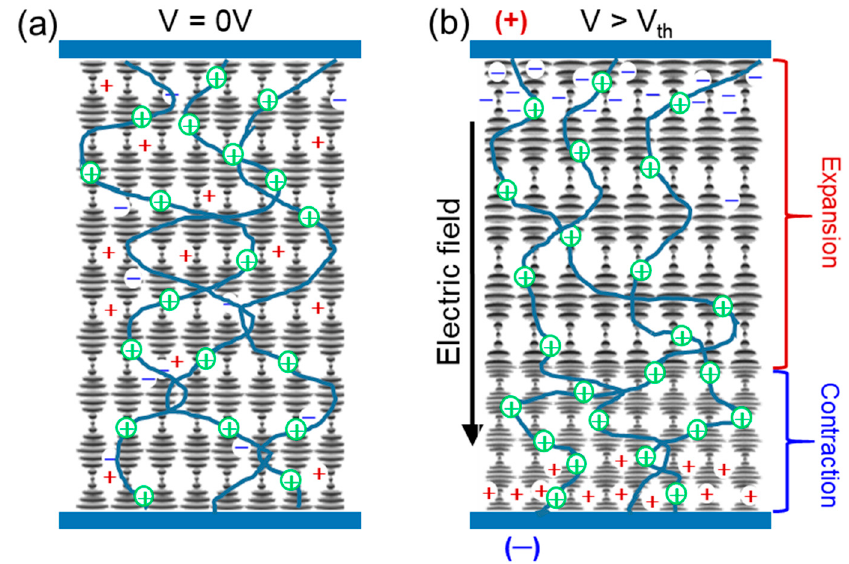
Figure 15. Schematic of the polymer network in a deformable PSCLC with Δε < 0: ( a ) with no applied field, ( b ) with a DC field applied between the top and bottom substrates. The blue lines represent the polymer network, the grey horizontal bars are the low-molecular weight CLC molecules, (+) and ( − ) are the free cationic and anionic impurities and ⊕ are trapped cationic impurities. Adapted from ref. [50].